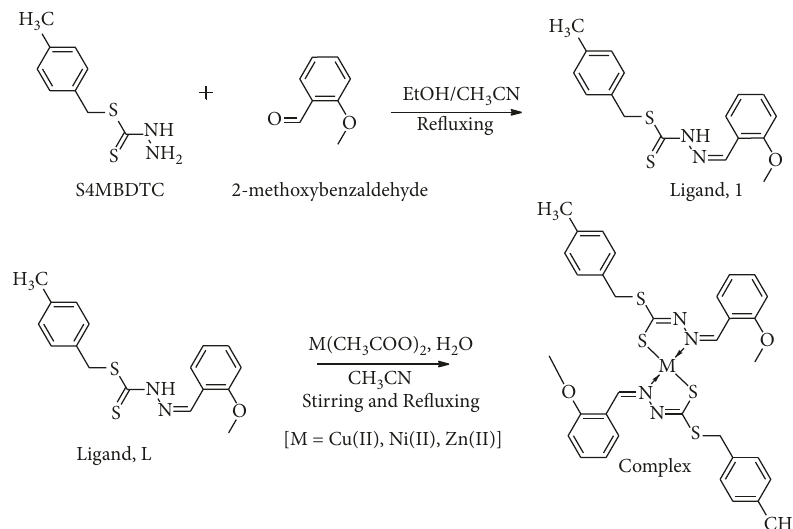
Scheme 1: Schematic representation of the ligand, 1, and its Cu (II), Ni (II), and Zn (II)